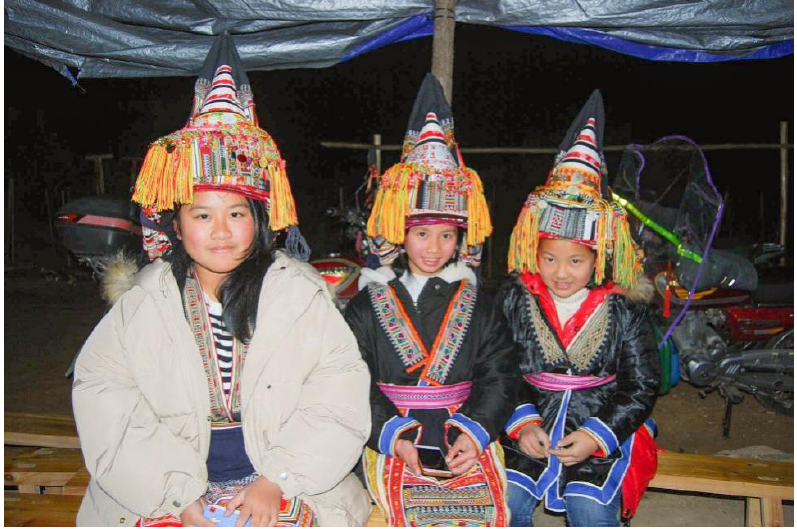
Figure 2. The virgin